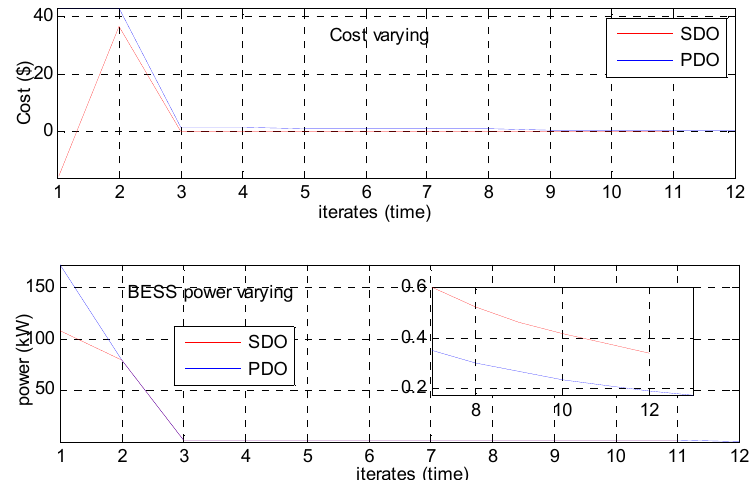
Figure 7. Utility fuel cost and BESS power change for the PDO and SDO algorithms.